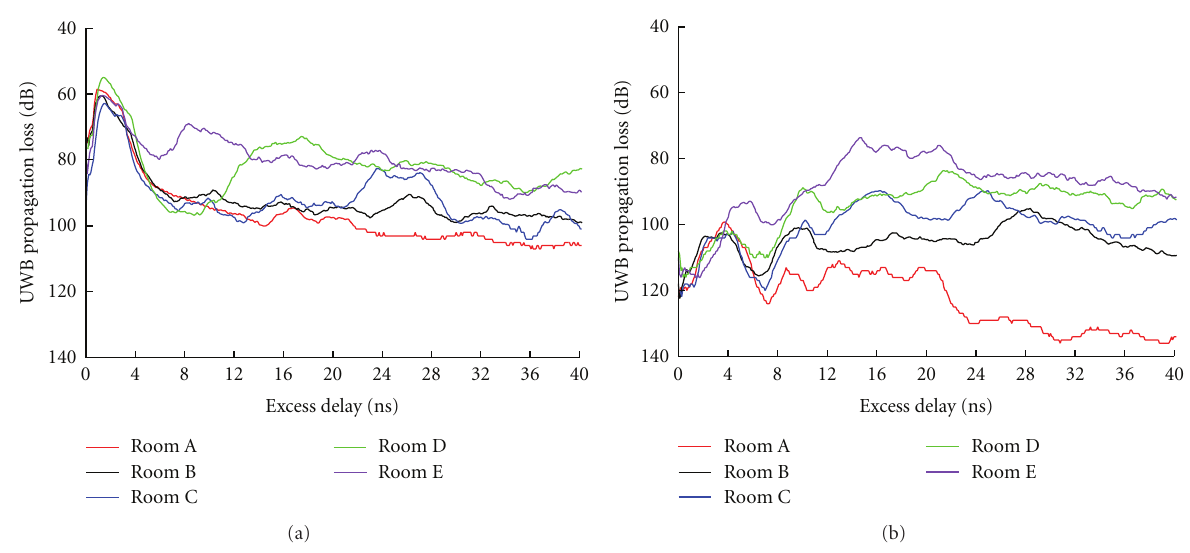
Figure 14: Measured average power delay profiles (averaged over 3ns): (a) LOS and (b) NLOS.